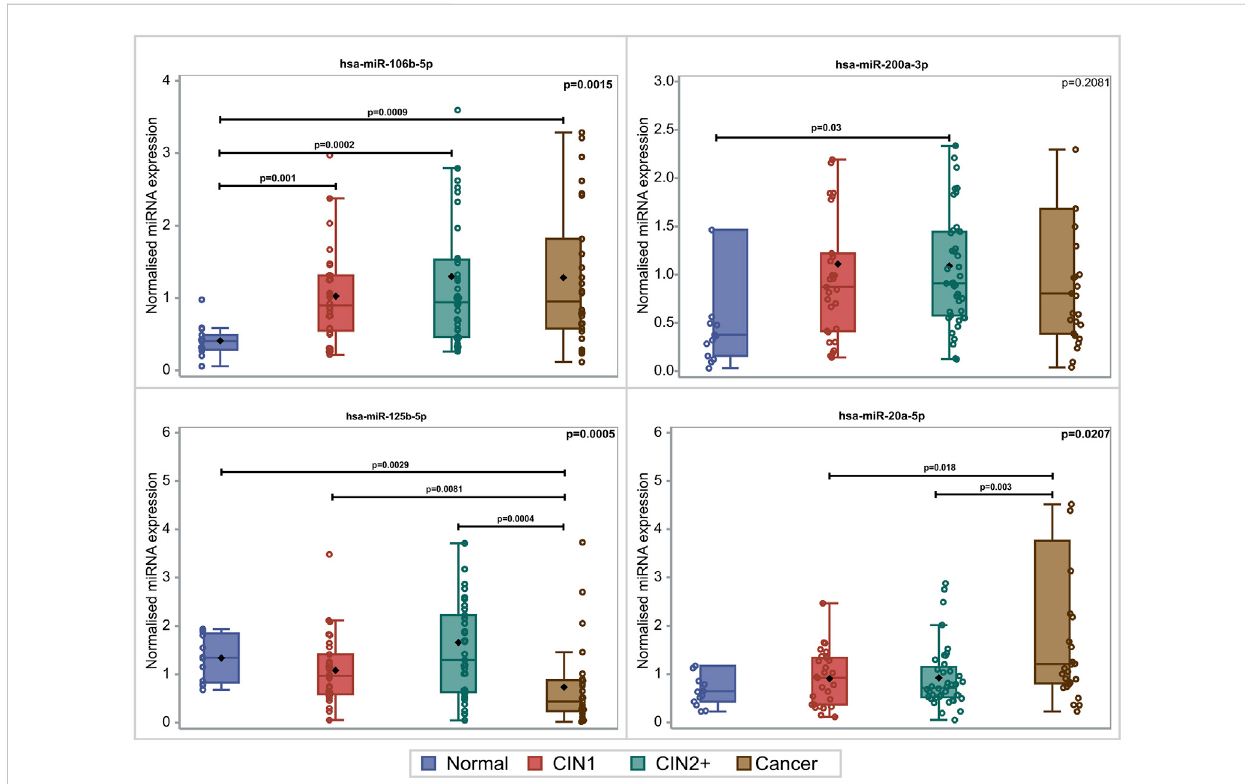
FIGURE 1 Box and whisker plots of the normalized miRNA levels in relation to the histological diagnosis. Box limits correspond to quartile 1 and quartile 3values,thelineswithintheboxescorrespondtothemedianvalues,andtherhomboidsymbolscorrespondtothemeanvalue.Whiskerlimitscorrespond totheminimumandmaximumobservationafteroutlierexclusion.Circlescorrespondtoactualmeasurements.However,extrememeasurementsdonot appear due to the scale of the vertical axis. p -values adjacent to box corners are the outcome of the Kruskal – Wallis test, and signi fi cant differences between pairs of histological groups ( via the Mann – Whitney U -test) are presented via the horizontal lines and the relevant p